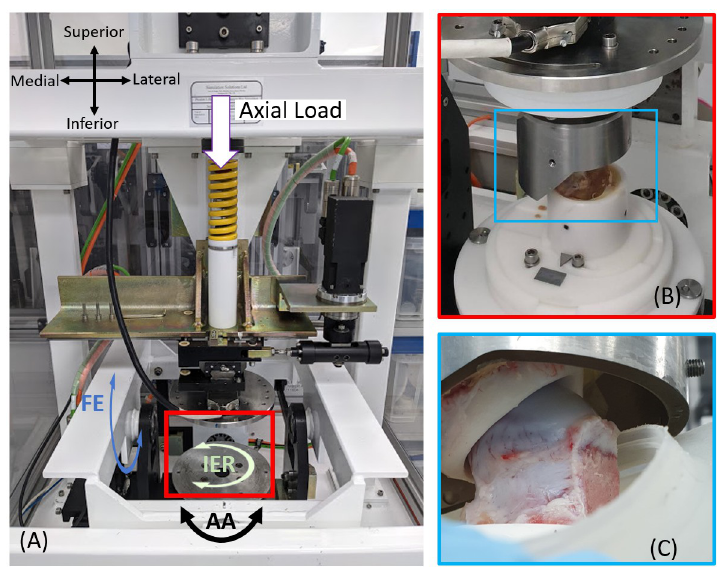
Fig 7. Simulator and mounted sample. (A) Single station hip simulator (SSHS); (B) right porcine hip sample cemented and mounted for simulation; (C) Femoral head and acetabulum position prior simulation. FE: flexion- extension, AA: abduction-adduction; IER: interior-exterior